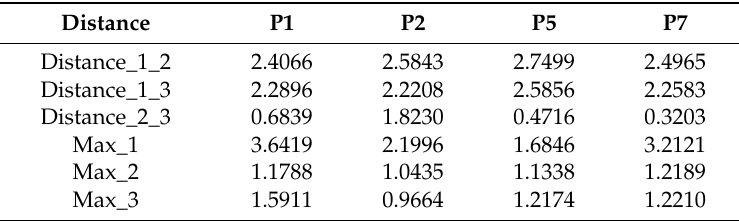
Table 3. The inter-class distance and the maximum inner-class distance of each class collected from all 4 users. Distance_a_b represents the inter-class distance between class a and class b. Max_a represents the maximum inner-class distance of class a.